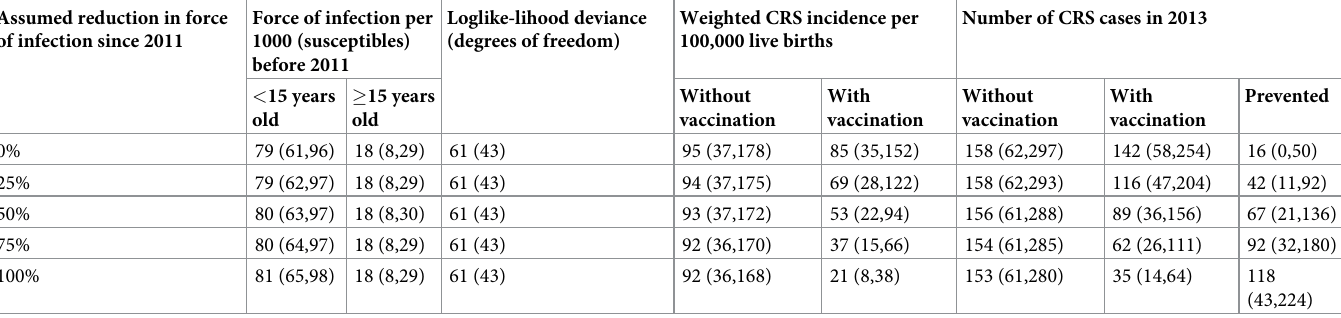
Table 2. Best-fitting values of the force of infection in Lao PDR before the 2011 SIA among participants aged < 15 and (cid:21) 15 years, obtained by the selected best-fit- ting model (model B) for different assumptions about the reduction in the force of infection after the SIA, and CRS incidence per 100,000 live births among women aged 15–44 years after weighting by the number of live births occurring among women in different maternal age groups. Assumed reduction in force of infection since